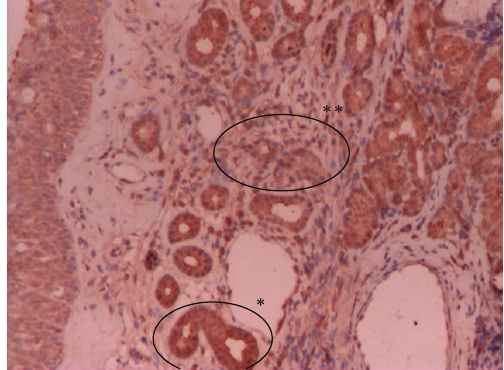
Figure 3: Middle turbinate mucosa: PLUNC positive (+++) IHC 100x. +++ PLUNC antibodies positivity in epithelium ( ∗ ) and in stroma ( ∗∗ ).